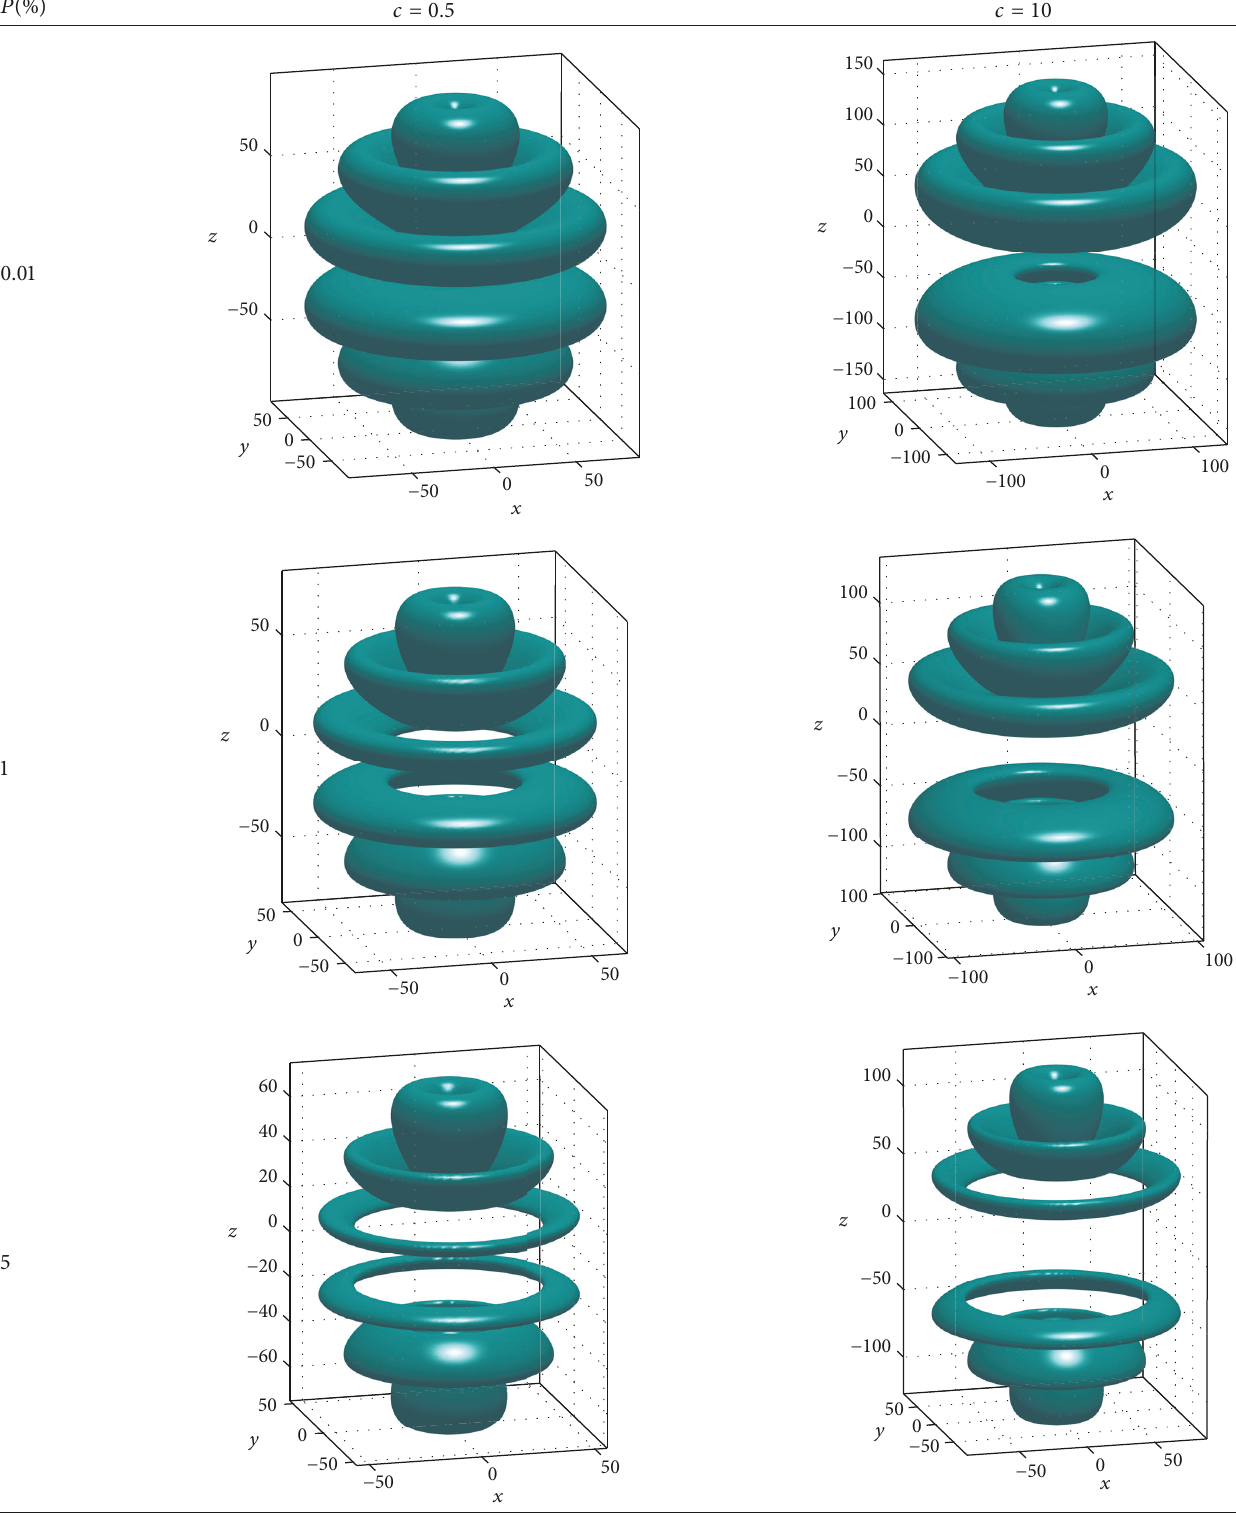
Table 3: The SPDs for various RPVs 𝑃 for (𝑛,𝑙, 𝑚) = (6,5, 0) (𝑏 = 0.5,𝑐 = 0.5, 10) . 𝑃 (%) 𝑐 = 0.5 𝑐 =